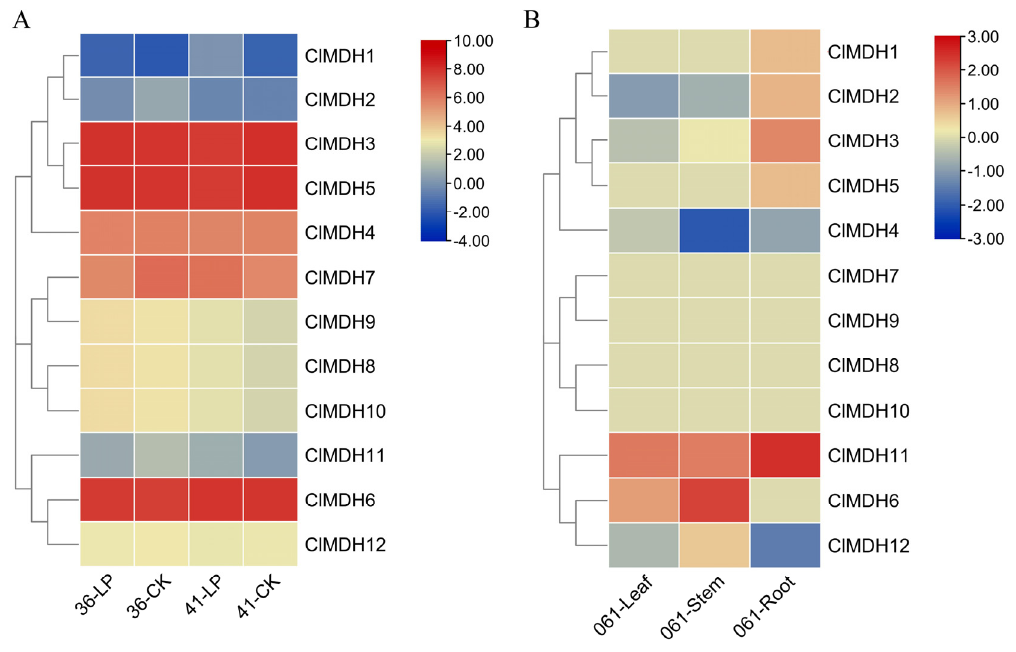
13 of 25 Figure 8. The putative transcription factor regulatory network analysis of ClMDH genes. Pink cir- cular nodes represent transcription factors; turquoise circular nodes represent ClMDH genes; and